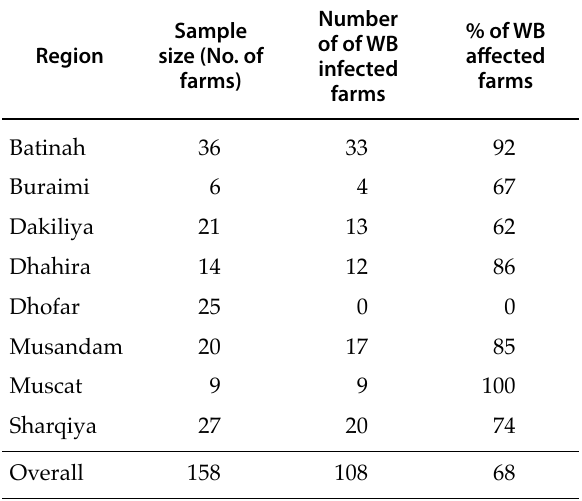
Table 1. Incidence of witches’ broom (WB) (% affected acid lime farms) in different regions of